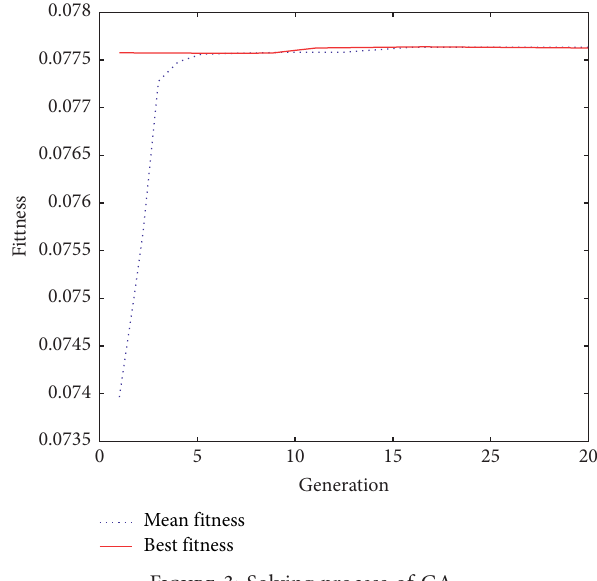
Figure 3: Solving process of